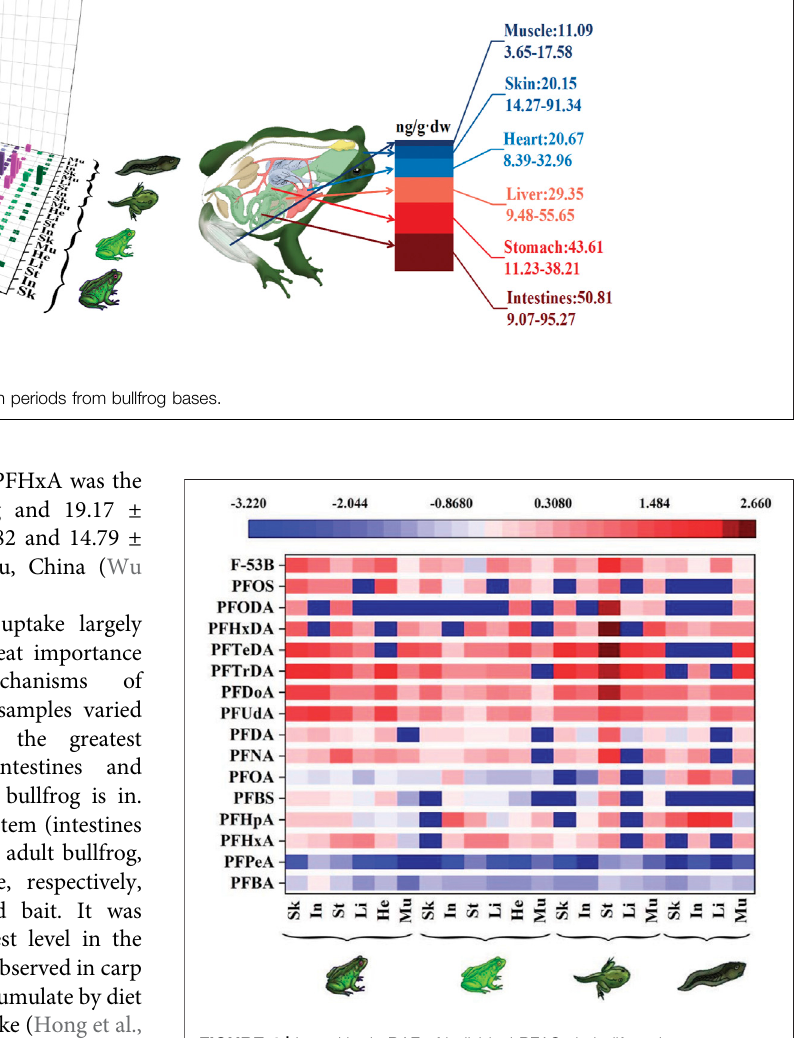
FIGURE 4 | Logarithmic BAF of individual PFASs in bullfrog tissues during different growth